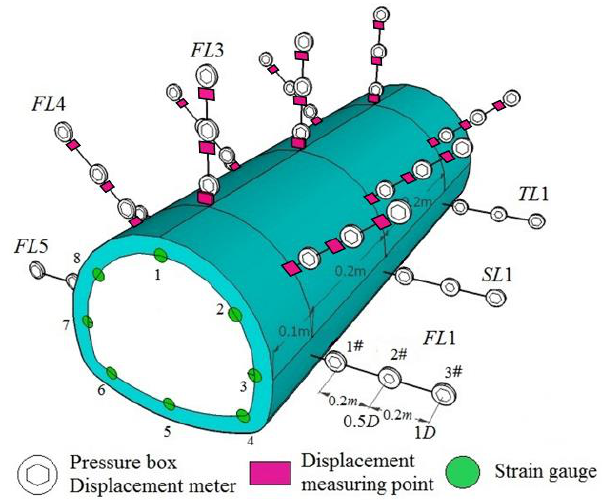
Figure 5. Schematic diagram of the model test.